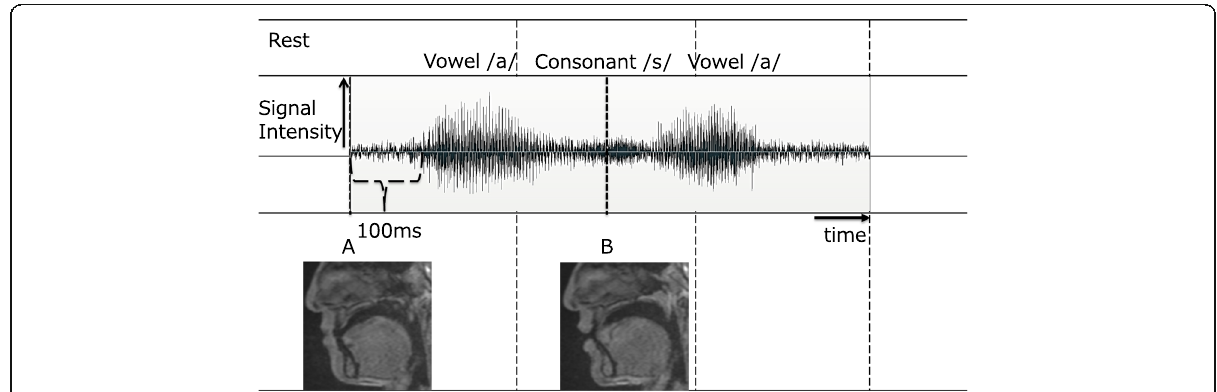
Fig. 2 A representative sound wave and timing. Signals obtained at the rest stage of 100 ms before production of the first vowel (stage A) and at the middle of production of the consonant (stage B) were